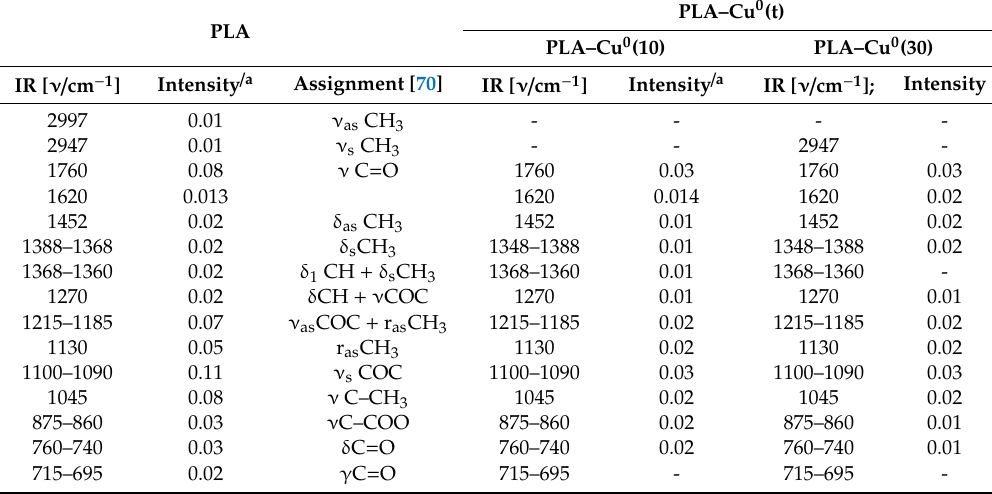
Figure 4. Attenuated total reflection Fourier transform infrared spectroscopy (ATR-FTIR) spectra of poly(lactic acid) non-woven and PLA–Cu 0 (10) and PLA–Cu 0 (30) composite. Table 4. Characteristic FTIR bands determined for PLA non-woven and PLA–Cu 0 (10) composite.